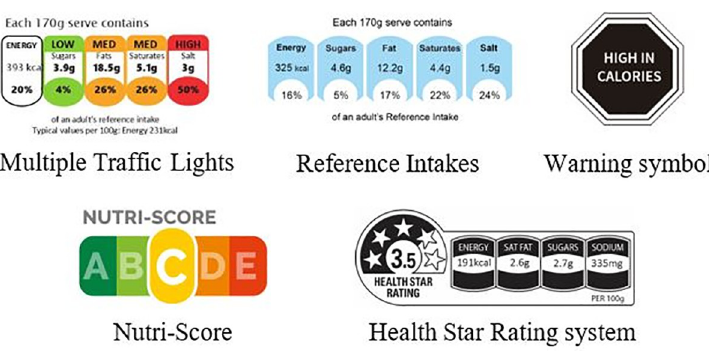
Fig 1. Front-of-pack nutrition labels tested in the present study. Three nutrient-specific FoPLs were included: (1) a numeric-only monochromatic label, the Reference Intakes, that was implemented worldwide in 2006 following a voluntary initiative of industrialists and displays the amounts in energy, fats, SFA, sugars and salt [35]; (2) a color- coded label, the Multiple Traffic Lights, implemented in the United Kingdom in 2004, that indicates the amounts of the same nutrients as the RIs, but with a colour associated with each nutrient depending on the amount (green—low, orange—moderate, red—high) [36]; and (3) a warning system, the Warning symbol implemented in Chile in 2016 and then in Peru in 2019, that advises when the level of a given unfavourable nutrient exceeds the limit established by the Chilean Ministry of health [37]. Second, two summary FoPLs were tested: (1) a graded color-coded label, the Nutri- Score, implemented in France in 2017 and later in 2018 in Belgium and Spain, that characterizes the overall nutritional quality of the food or beverage using a graded scale of five colors from dark green (associated with the letter A) to dark orange (associated with the letter E) [17] and (2) a hybrid FoPL, the Health Star Rating system, implemented in Australia and New Zealand in 2014, that combines a graded scale of stars and information on nutrient amounts